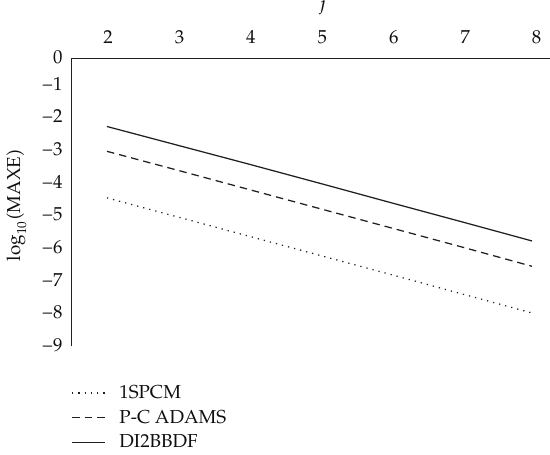
(cid:3) MAXE (cid:4) against j . 10